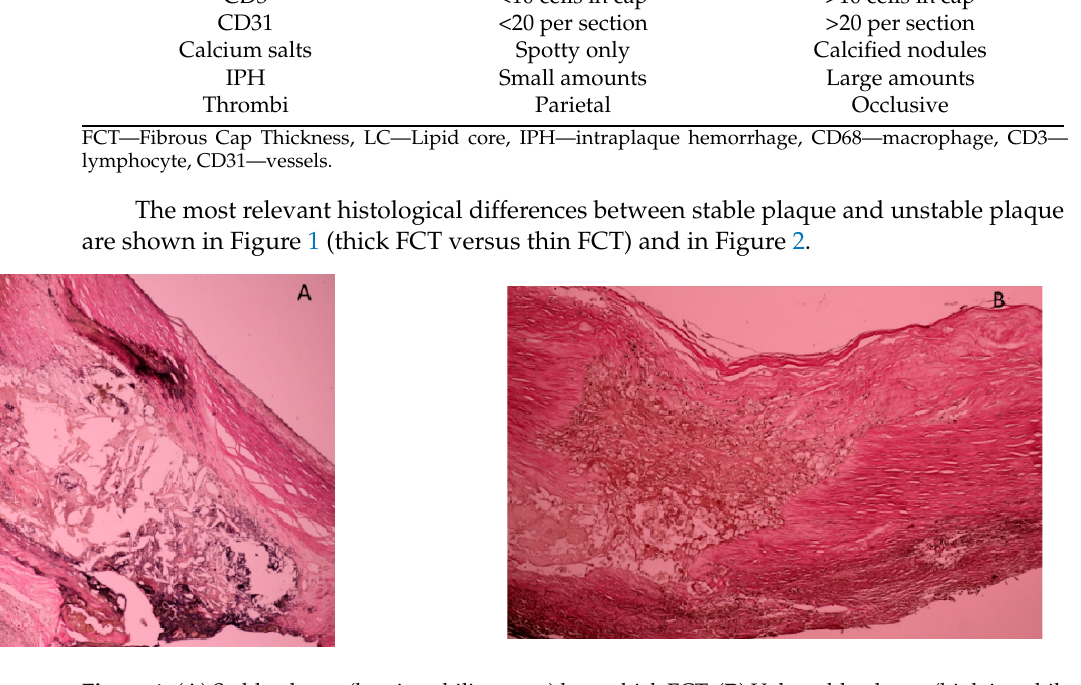
Figure 1. ( A ) Stable plaque (low instability score) has a thick FCT. ( B ) Vulnerable plaque (high instability score) has a thin FCT erosion (elastic Van Gieson staining of the elastic tissue; × 20 magnification).